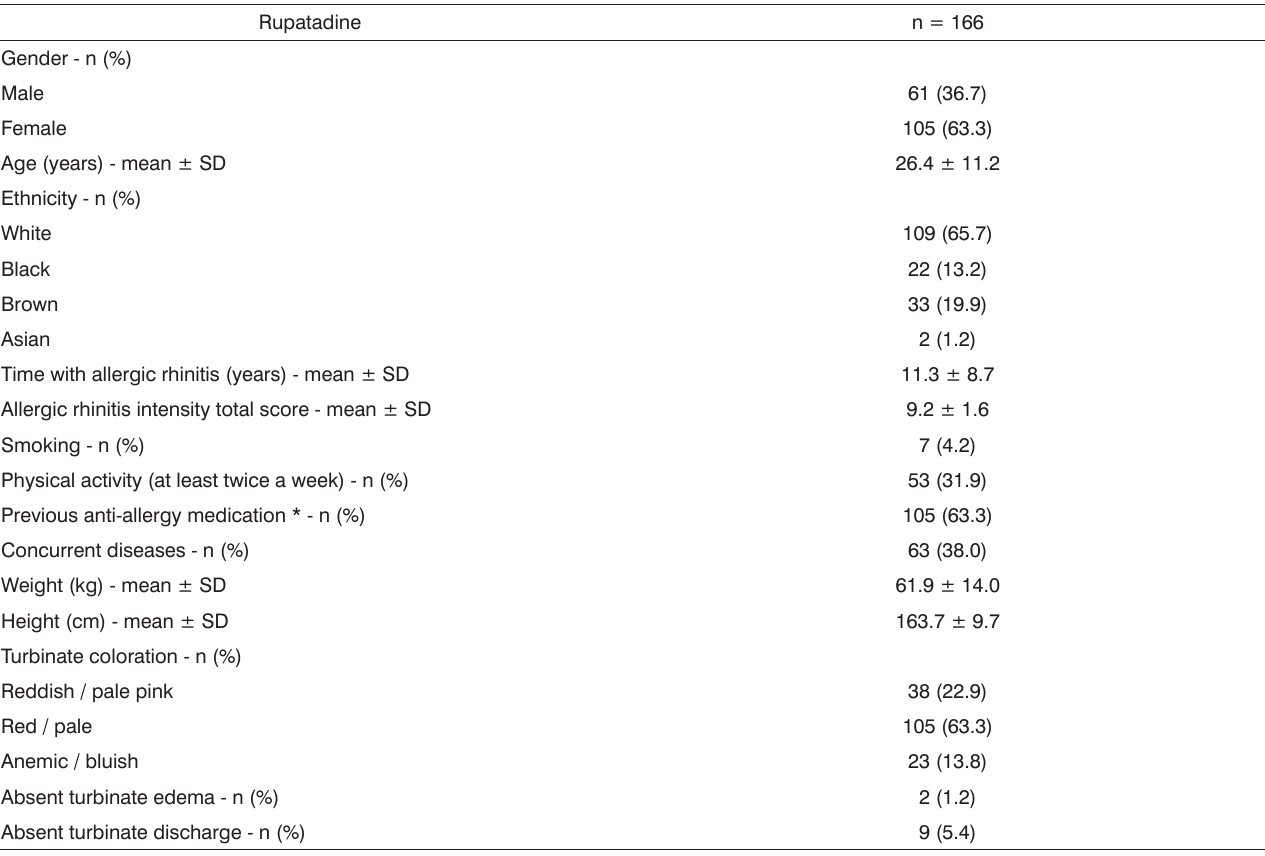
Table 1. Baseline clinical and demographic characteristics (before enrollment) PIT sample Rupatadine